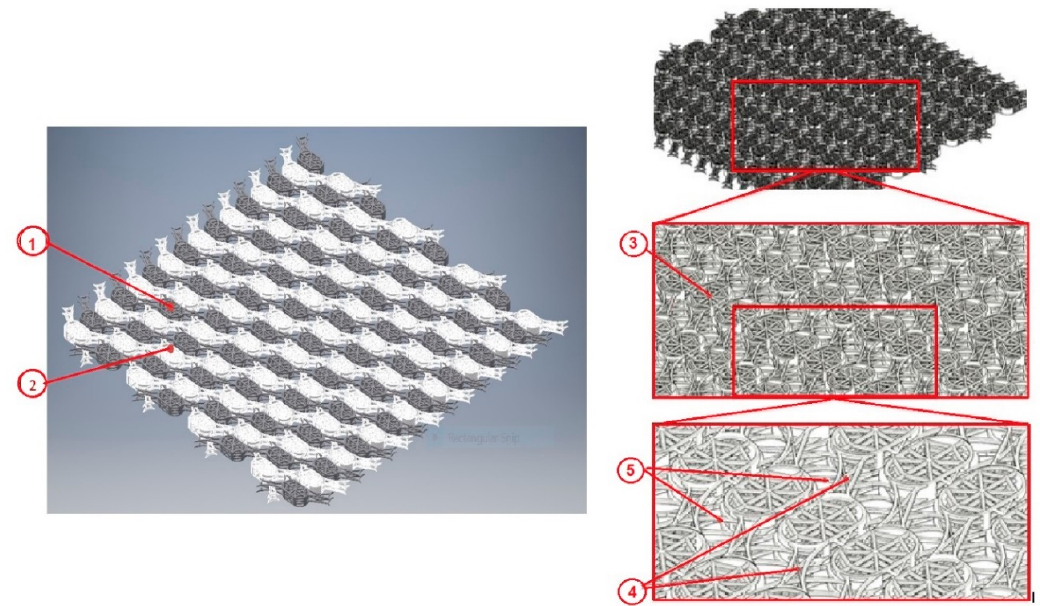
Figure 7. Interconnected layers of the modular system. Left panel-The fixed layer ① is assembled with the movable layer ② so that translations can be performed in the Ox and Oy directions, while maintaining the position of the layer ① . Right panel-The component elements of the cranial prosthesis presented in isometric view, consisting of four basal cells defined in two constructive forms ③ , the rigid connecting bridge ④ and the flexible connecting bridge ⑤ .